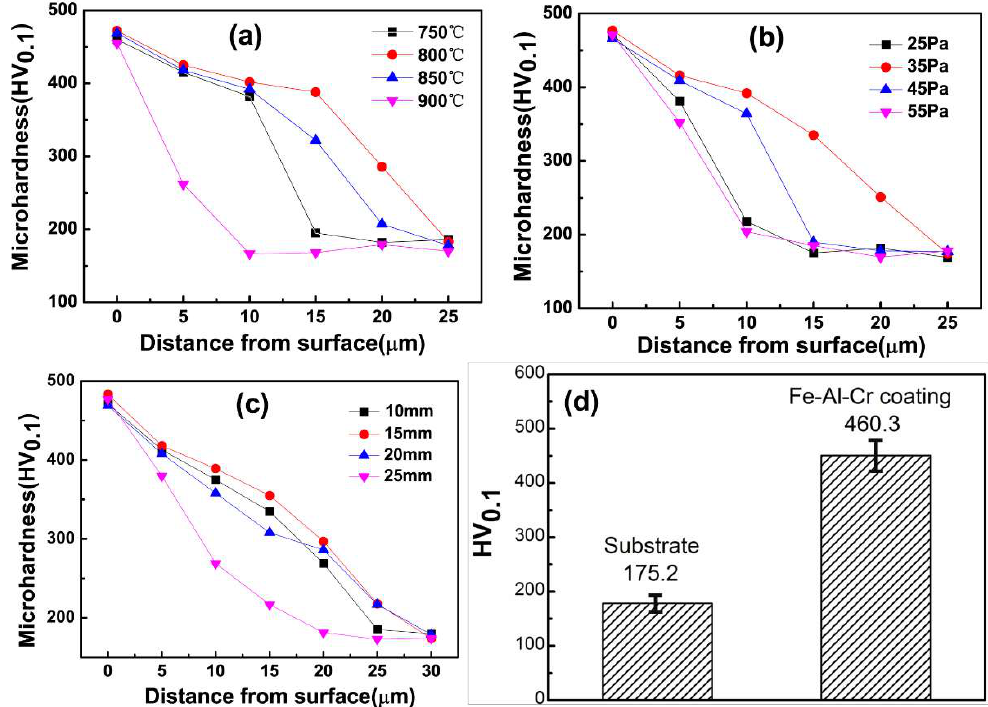
Figure 11. ( a – c ) The microhardness distributions from the surface to the substrates of the Fe-Al-Cr coatings obtained at different parameters; ( d ) microhardness of the Q235 steel and Fe-Al-Cr